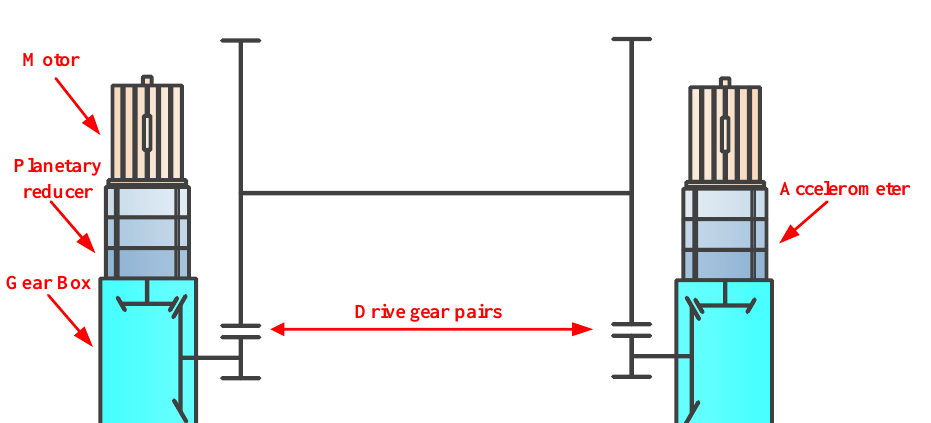
Figure 16. Shipborne antenna.